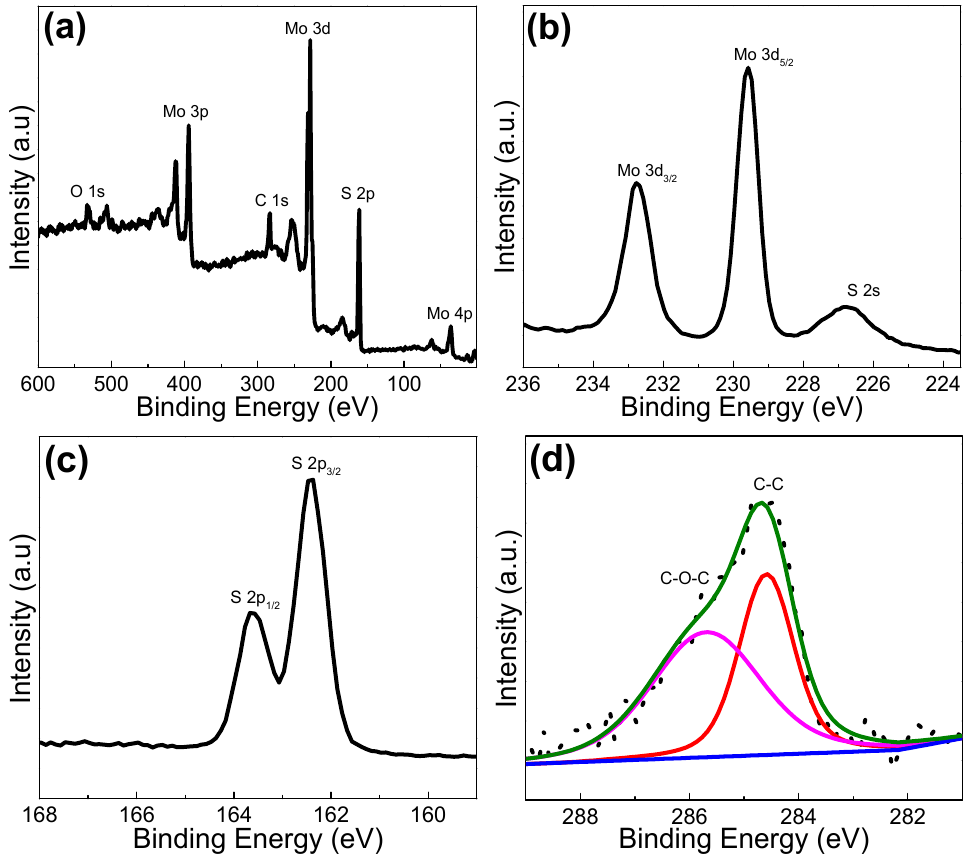
Figure 2. XPS spectra of MoS 2 @carbon composite fiber membranes: ( a ) the survey scan; ( b ) Mo 3d; ( c ) S 2p; ( d ) C 1s.